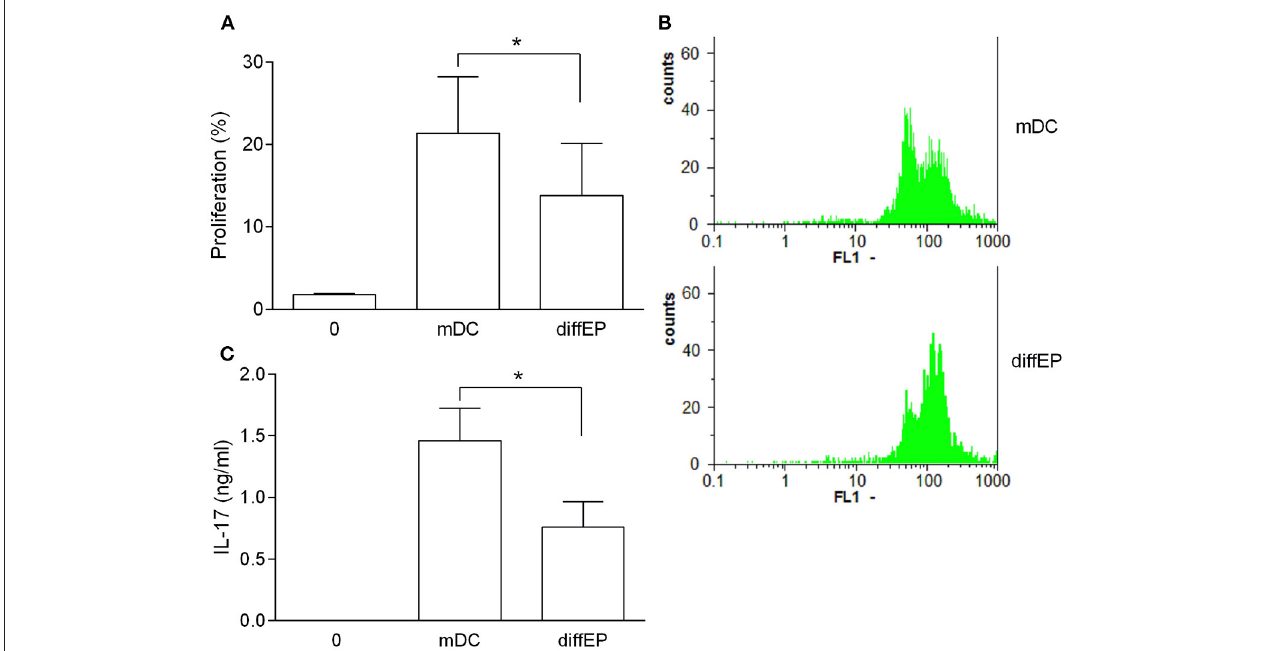
FIGURE 3 | Effects of murine EP-treated DC on allogeneic reactivity. BMDC were obtained from C57BL/6 mice. Their maturation was induced by LPS in the absence (mDC) or presence of 3.1mM EP (diffEP). They were co-cultured with CD4 + T cells purified from BALB/C mice lymph nodes. Cell proliferation was determined by CFSE assay (A,B) . IL-17 levels were determined in cell culture supernatants by ELISA (C) . Data are presented as mean + SD from at least three independent experiments. Data in (B) are representative plots. * p < 0.05, diffEP vs. mDC, one way ANOVA followed by Tukey’s multiple comparisons